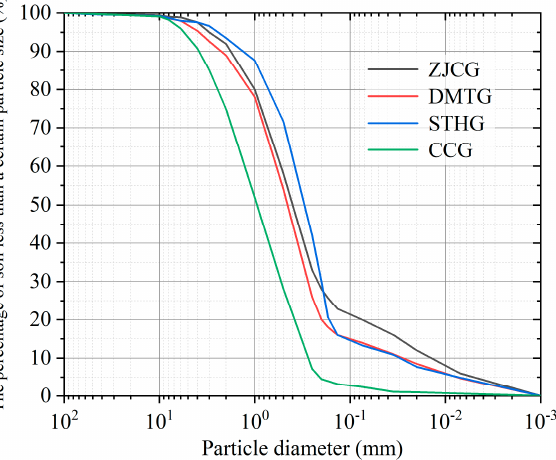
Figure 3. Gradation curves of the overlying accumulation layer in the formation area of study area. Table 2. Soil parameters of the overlying accumulation layer in the formation area of Laomao Mountain debris flow. Name of the Soil Sample